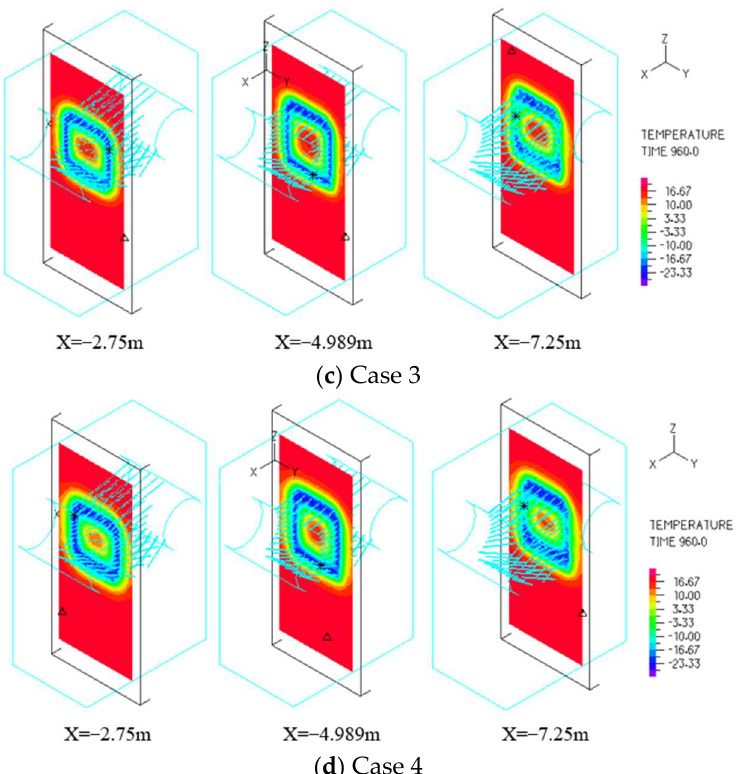
Figure 8. Temperature distribution clouds at each cross-section under different working conditions. The temperature variation curves at the observation points of the C7 observation path under different termination temperature cooling plans are shown in Figure 9.